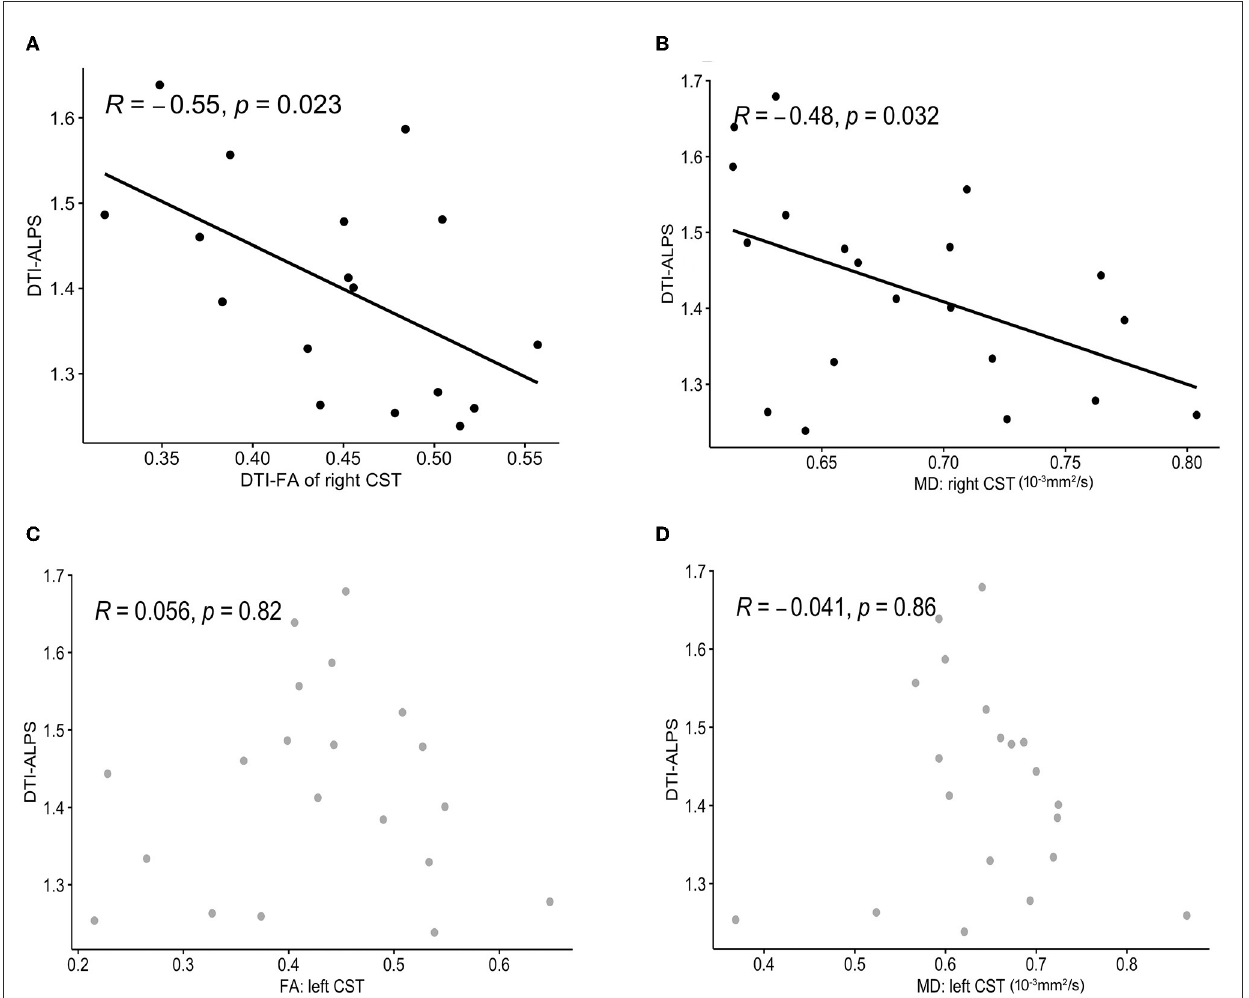
FIGURE6 Correlation analysis between the DTI-ALPS index and CST metrics. A significant negative correlation is observed between the left DTI-ALPS index and FA (A) , MD (B) of the right CST. There was no significant correlation between the left DTI-ALPS index and the left CST: FA (C) , MD (D) . DTI-ALPS, diffusion tensor image analysis along the perivascular space; CST, corticospinal tract; FA, fractional anisotropy; MD, mean